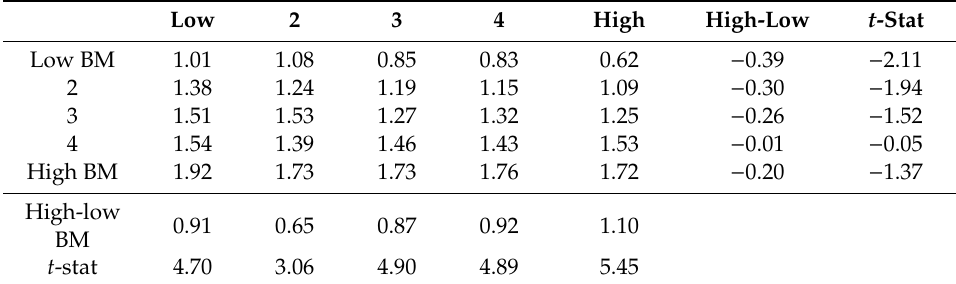
Table 15. Average returns from double-sorted quantile portfolios (sorted by book-to-market ratio and Geske’s forward default probability). From the data for July 1963 to December 2013, at the end of each month, stocks are independently sorted into 5 × 5 portfolios based on the book-to-market ratio and Geske’s forward default probability. The table shows average returns for each of 25 portfolios. Small-big is the return di ff erential between the small and big firm portfolios within each default quantile. High-low is the return di ff erential between the high and low default probability firms within each size quantile. t -statistics are calculated using Newey-West standard errors.